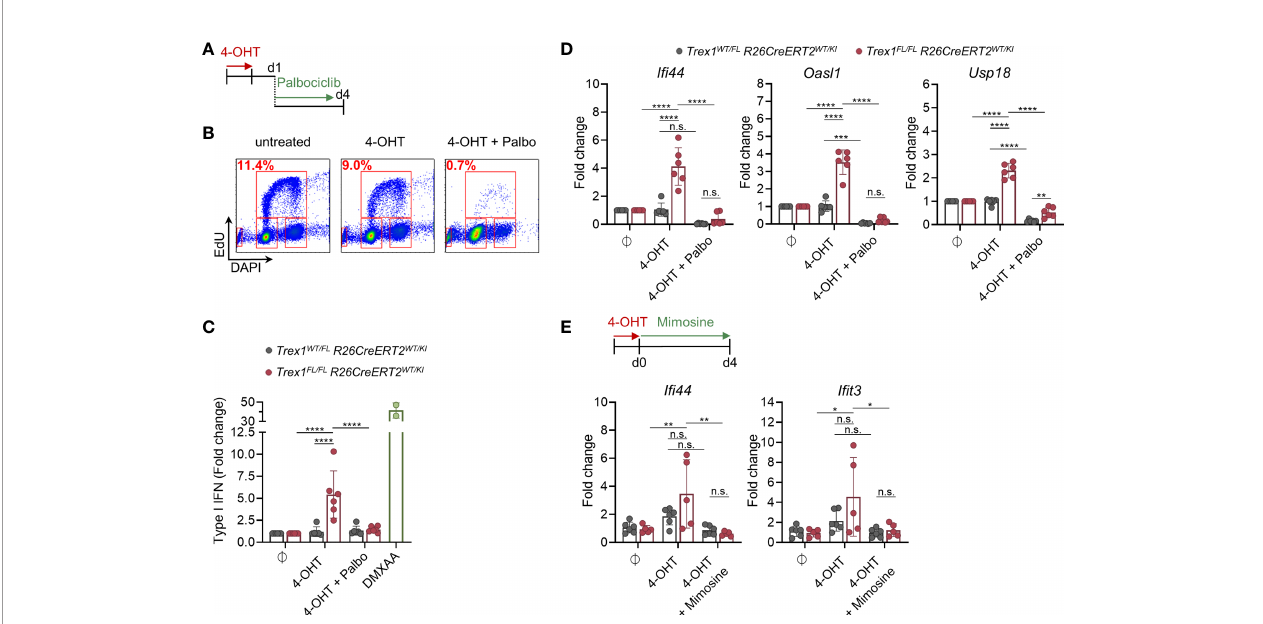
FIGURE 6 | IFN response upon induced loss of TREX1 in macrophage cultures requires ongoing proliferation. (A) Trex1 FL/FL R26 CreERT2 and control BMDMs were treated with 4-OHT in vitro for 22h. 1 day after end of 4-OHT induction, CDK4/6 inhibitor Palbociclib was added to arrest the cells in G1. (B) Veri fi cation of proliferative arrest after 72h of Palbociclib treatment (d4 after end of 4-OHT) as determined by fl ow cytometric quanti fi cation of EdU incorporation and DNA content (DAPI). Representative of 3 independent experiments. (C) Quanti fi cation of type I IFN bioactivity in supernatant from BMDMs treated with 4-OHT and Palbociclib (n = 6 each genotype, pooled from 3 independent experiments). Supernatant was added to 1x10 4 LL171 luciferase IFN-reporter cells followed by quanti fi cation of luciferase activity. Supernatant of WT BMDMs treated with DMXAA served as high control. (D) ISG transcript levels in BMDMs after 72h of Palbociclib treatment (d4 after end of 4-OHT) as determined by qRT-PCR (n = 6 for each genotype, pooled from 3 independent experiments). Fold change compared to mean of untreated control cells (n = 6) is shown. (E) Trex1 FL/FL R26 CreERT2 and control BMDMs were treated with 4-OHT in vitro for 22h. At the end of 4-OHT induction, Mimosine was added to arrest the cells in G1. ISG transcript levels in MEFs after 96h of Mimosine treatment (d4 after end of 4-OHT) as determined by qRT-PCR ( Trex1 WT/FL R26 CreERT2 n = 6, Trex1 FL/FL R26 CreERT2 n = 5, pooled from 2 independent experiments). ****p < 0.0001, ***p <